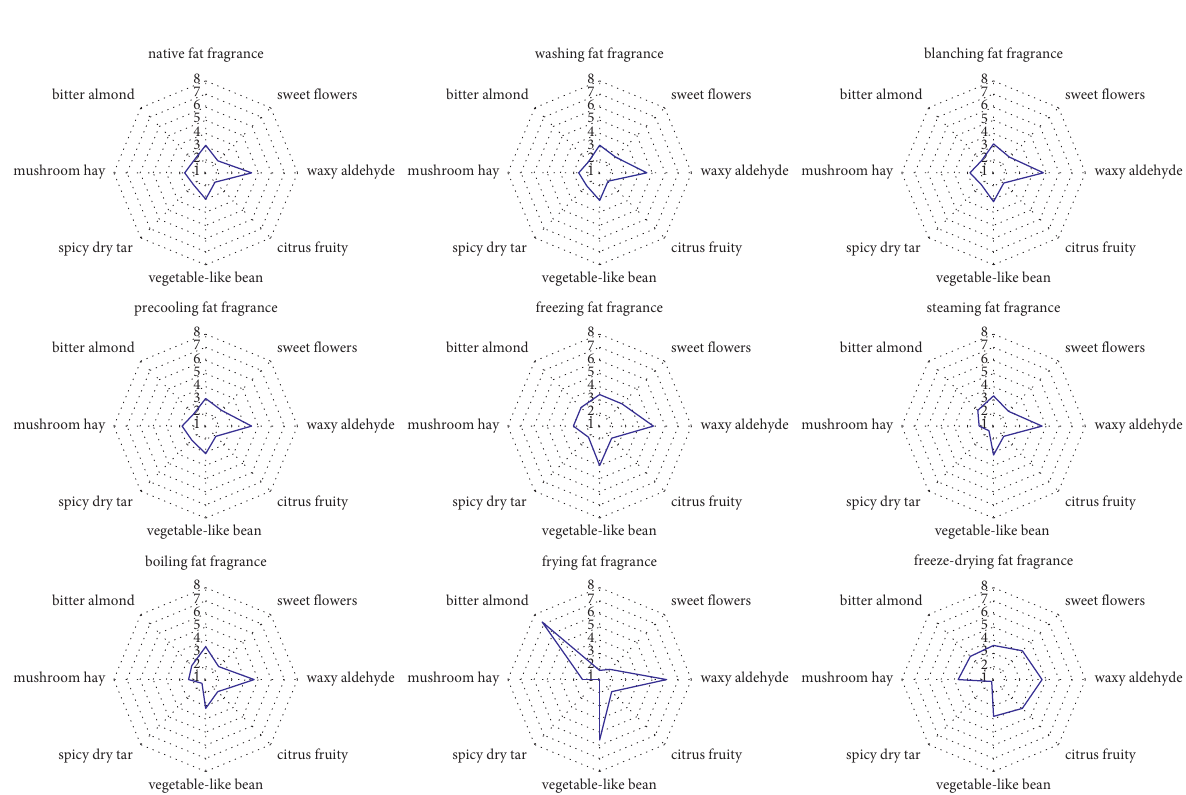
Figure 6: Radar charts of the sensory analysis of peas with scores ranging from 0 (no perception) to 9 (strong